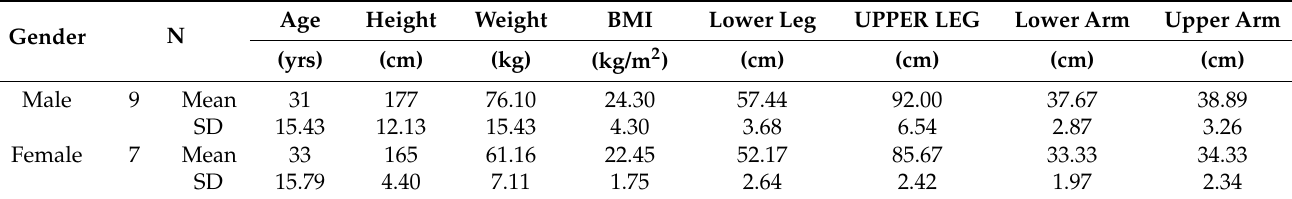
Table 3. Demographics and anthropometric data of